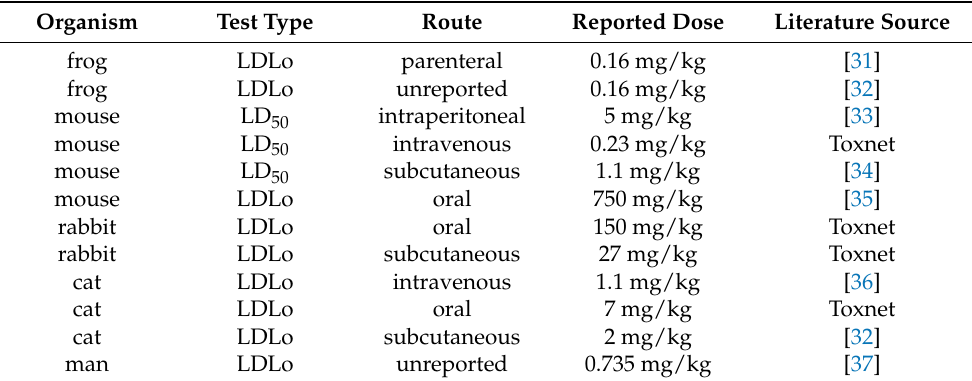
Table 1. Published acute and subacute toxic parameters of